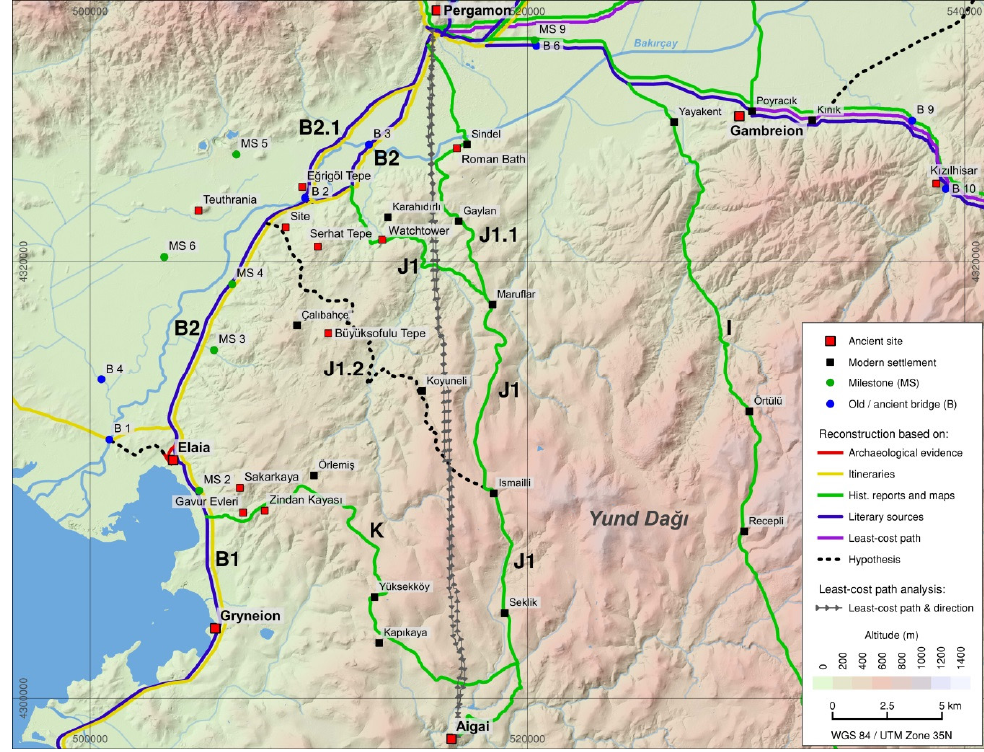
Figure 21. Calculated least-cost paths and reconstructed routes between Aigai and Pergamon and between Aigai and the ancient coastal route.